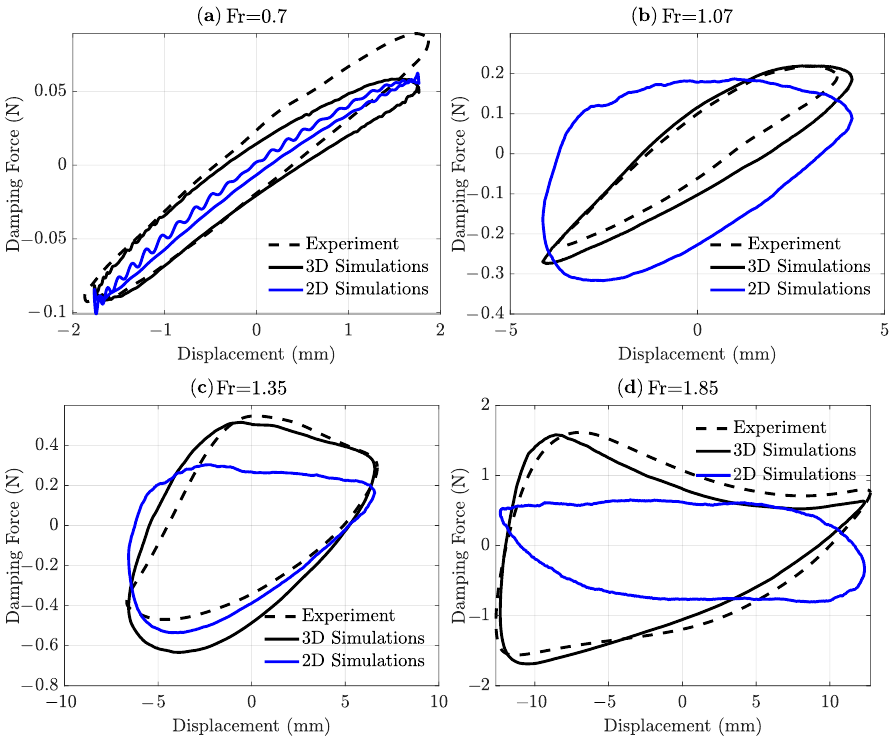
Figure 5. Comparison between the two-dimensional and the three-dimensional simulations using the phase average of the damping forces for different Fr numbers. ( a ) Fr = 0.7, ( b ) Fr = 1.07, ( c ) Fr = 1.35, ( d ) Fr =